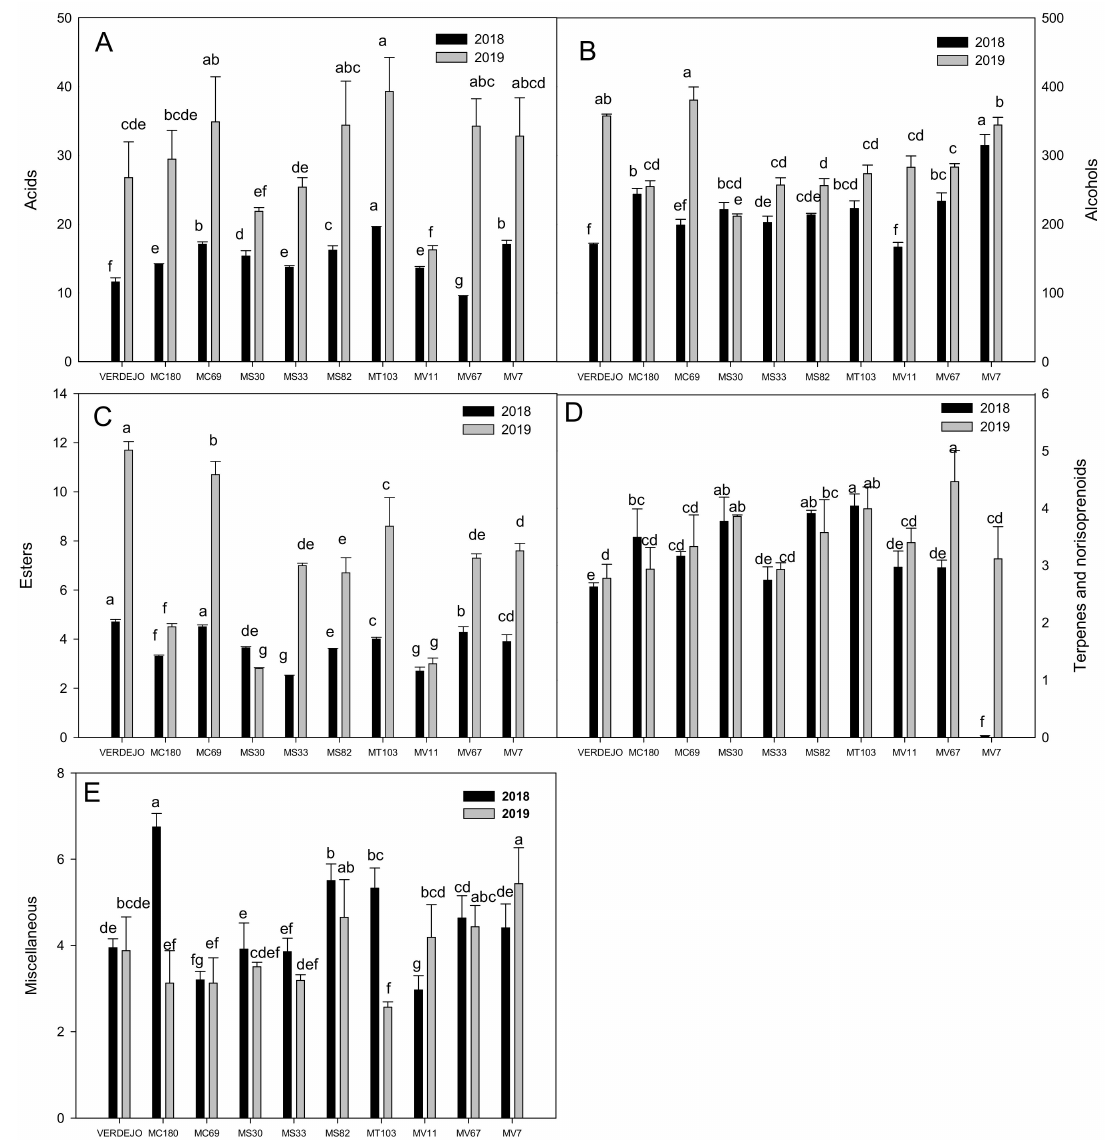
Figure 1. Total concentration of volatile compounds within the di ff erent aromatic families: Acids ( A ), alcohols ( B ), esters ( C ), terpenes and norisoprenoids ( D ), and miscellaneous ( E ). Comparison between the di ff erent crosses and Verdejo as control, in two di ff erent seasons (2018 in black and 2019 in grey) expressed as mg / L (ppm). Di ff erent letters are specific to each year and show significant di ff erences (ANOVA, LSD